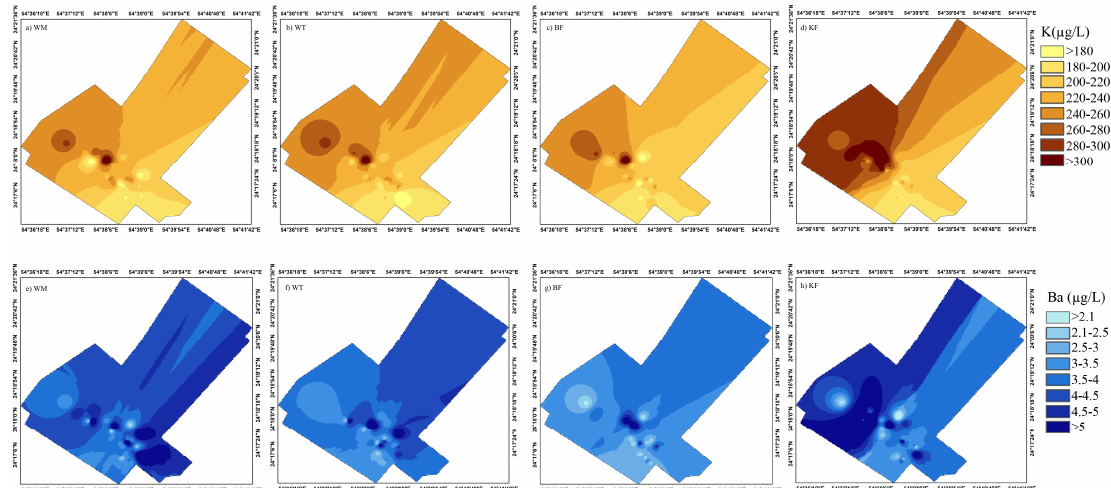
Figure A3. Spatial variation of heavy metals; ( a – d ) Potassium concentrations for the four sampling points WM, WT, BF and KF respectively. ( e – h ) Barium concentrations for the four sampling points WM, WT, BF and KF respectively.